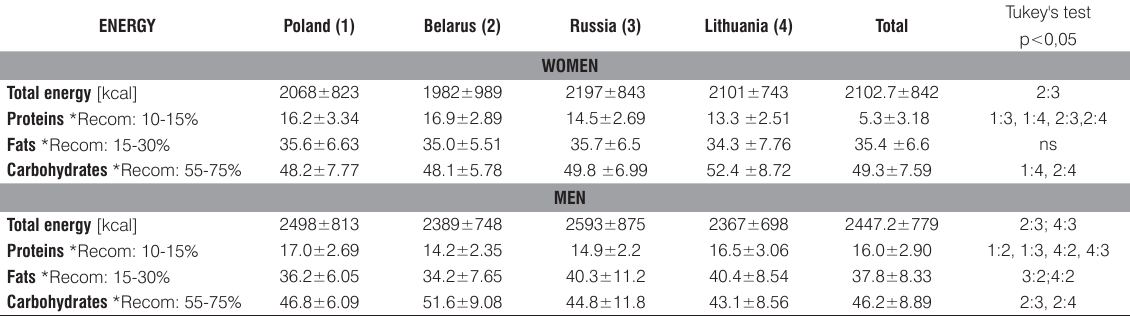
Table 4. The percentage share of proteins, fats and carbohydrates as energy sources in Daily Nutrient Ratio (DNR) in female and male groups from four countries.